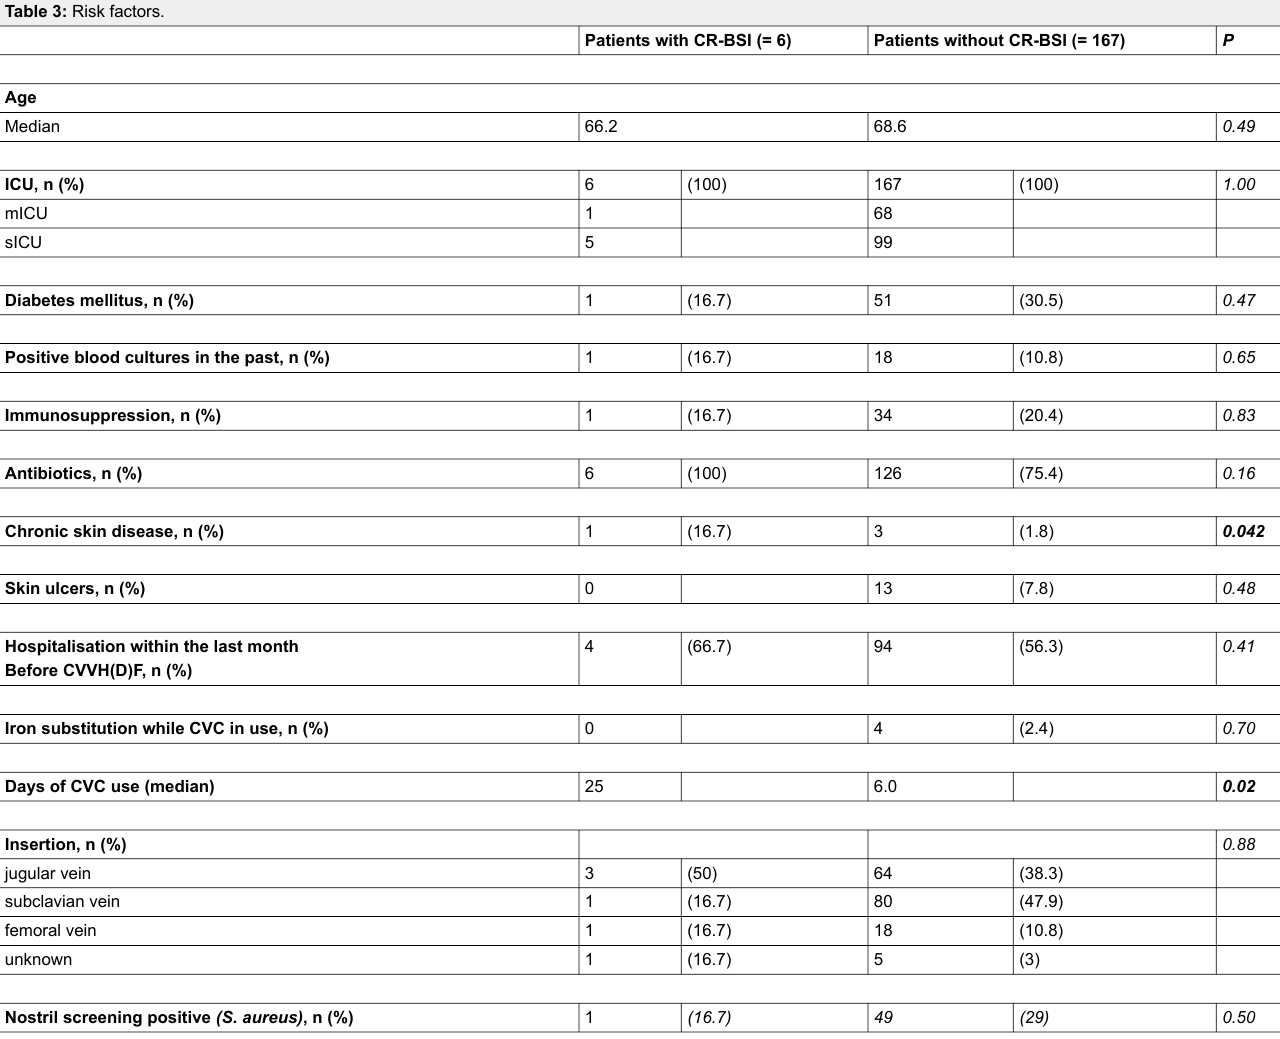
Table 3: Risk factors.